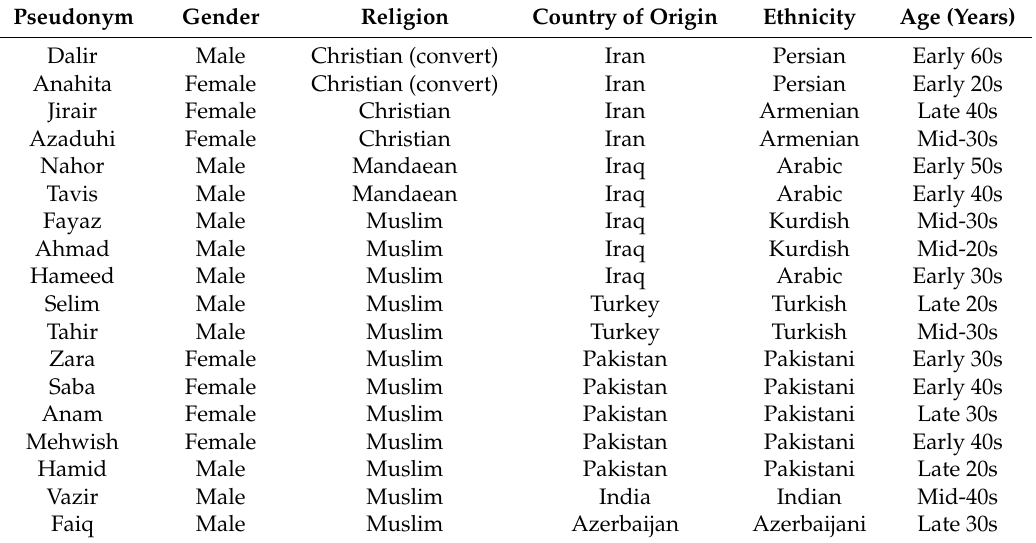
Table 1. Participant